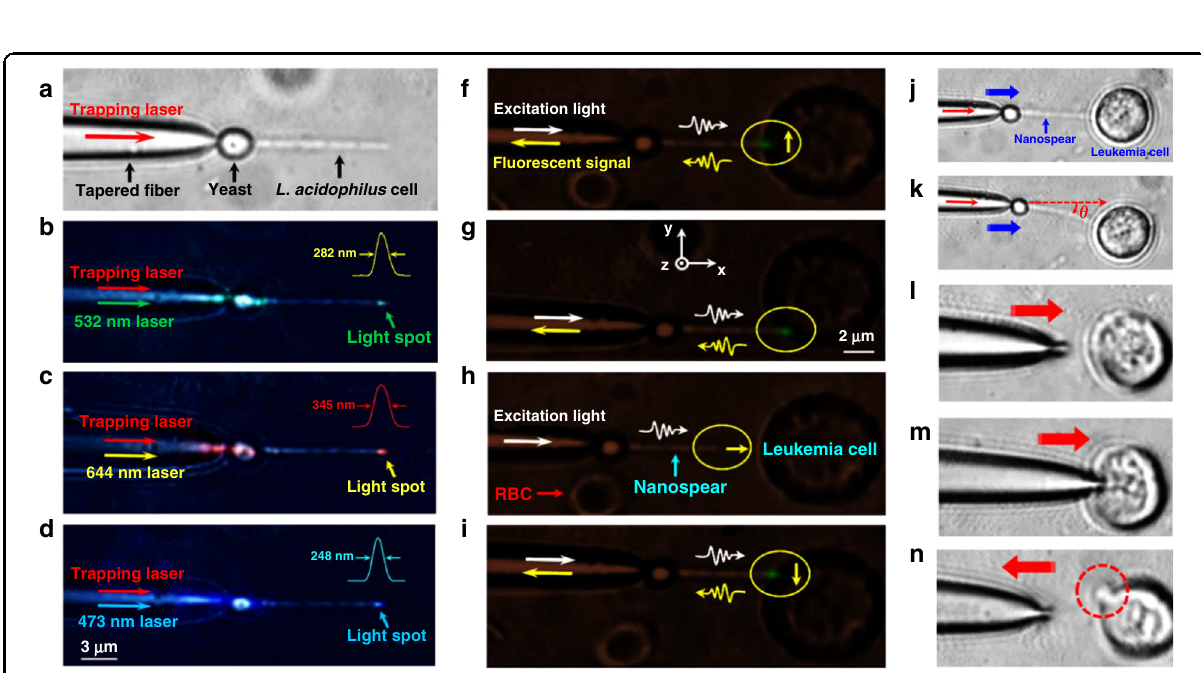
Fig. 3 Microscopy images illustrating the construction of a living nanoprobe from yeast and bacteria single units, together with a sequence of actual use for probing a single leukaemia cell. a Bionanospear assembled on an optical fi bre using single yeast and fi ve L. acidophilus cells. b – d Dark- fi eld images showing b 532 nm (green) light, c 644 nm (red) light and d 473 nm (blue) light propagating through the bionanospear and focused into subwavelength dimension spots (insets show line intensity pro fi les for the lateral direction in the spots). f – i Local fl uorescence excitation/detection from a single leukaemia cell in human blood using the bionanospear. f Dark- fi eld optical image of the bionanospear and leukaemia cell separated by a 3- μ m gap. j – n Flexibility testing by pushing the bionanospear against the cell membrane of a leukaemia cell. Reproduced from ref.